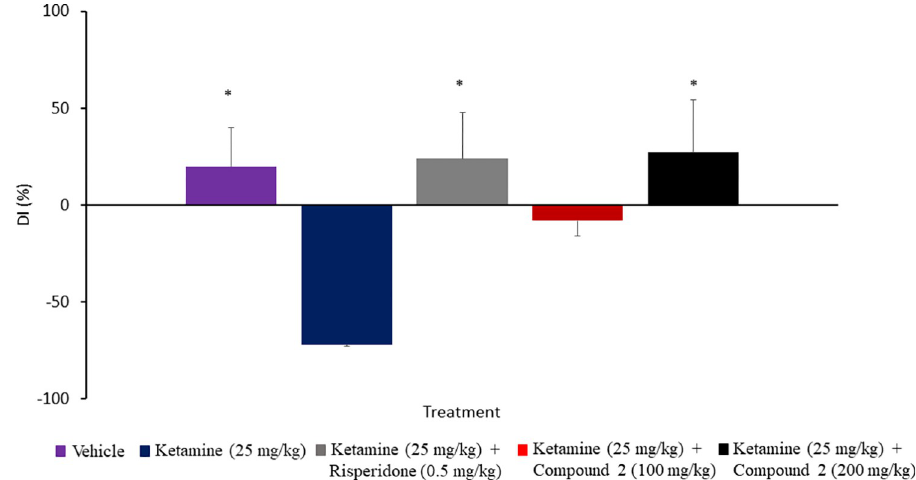
Fig 6. Effect of compound 2 on ketamine-induced non-spatial working memory impairment. Rats were injected with ketamine for 10 days, then left undisturbed for 3 days. On day 14th, vehicle, risperidone or compound 2 was given, and the rats were trained for 15 min to induce the recognition memory in the sample trial. After 24 h, rats were tested for memory retention in the choice trial. Rats treated with 200 mg/kg compound 2 showed significantly stronger memory retention than rats treated with ketamine and trained for 15 min. Data are expressed as a mean ± S.E.M (n = 8–12) and analysed by One-way ANOVA followed by Tukey’s post hoc test, � p < 0.05 compared to the schizophrenia control